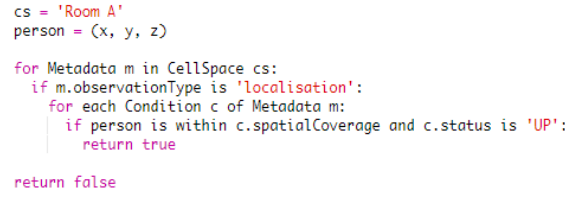
Figure 6. Pseudocode for localisation related